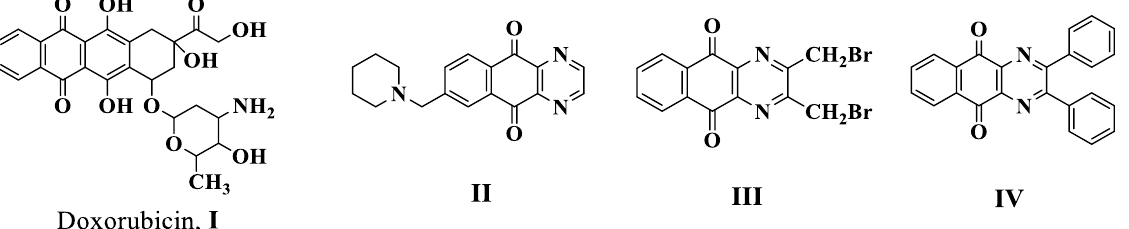
Figure 1. Structure of doxorubicin I and benzo[ g ]quinoxaline derivatives II –